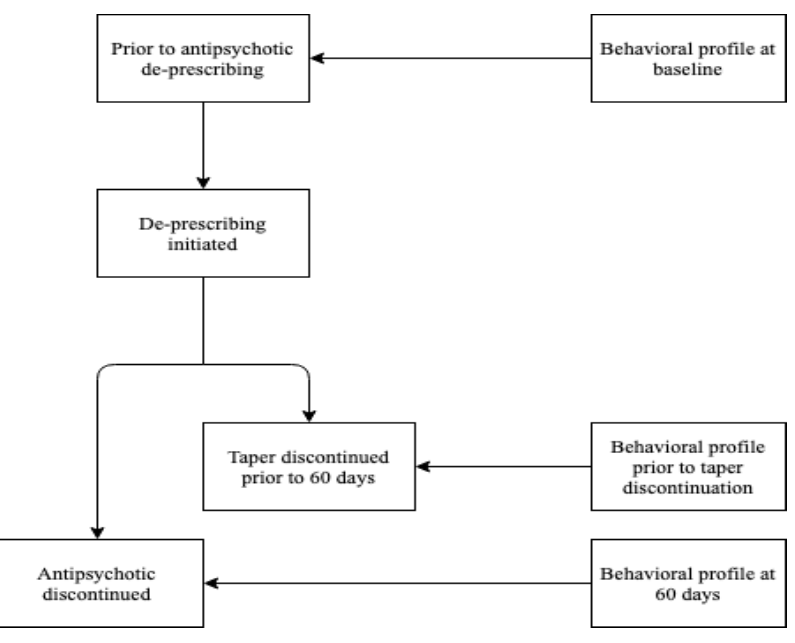
Figure 1. Schematic representation of the Care Pathway.